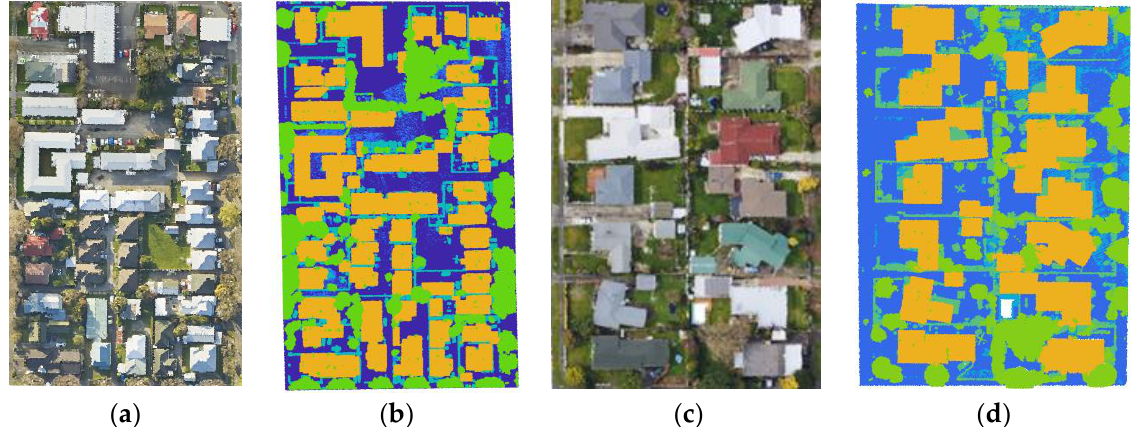
Figure 10. The study areas of OpenTopography datasets. ( a ) The true-color image of S1; ( b ) the point cloud data of S1, which is colored according to different labels; ( c ) the true-color image of S2; ( d ) the point cloud data of S2, which is colored according to different labels.